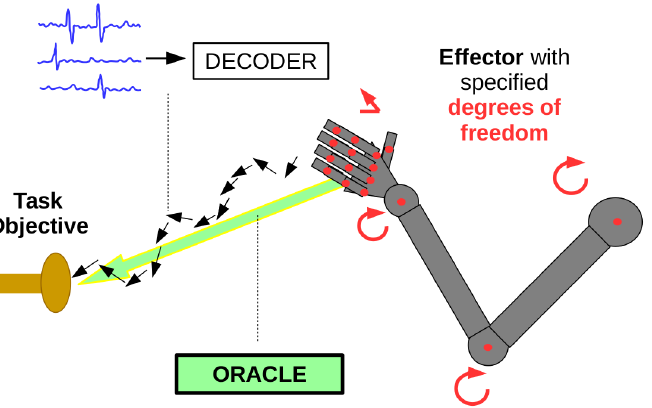
Fig 1. A BCI has an effector , such as a robotic arm, with predefined degrees of freedom. Given a task objective (e.g. an objective function corresponding to reaching and grasping a target), an intention-oracle can be computed to provide the intended updates to the arm kinematics. The actual trajectory of the arm is evaluated deterministically from the neural activity via the decoder . In practice, the oracle update would be recomputed at each timestep to reflect the instantaneous best movement in the direction of the